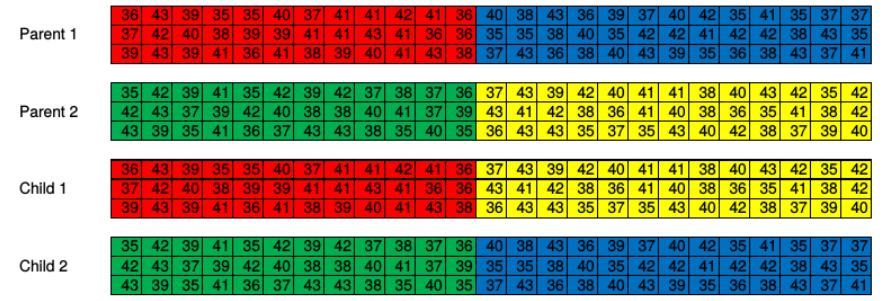
Figure 7. Crossover operation for power allocation.